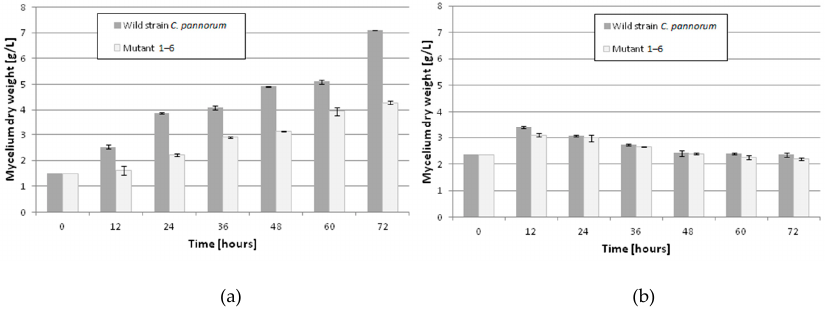
Figure 4 . Cell growth rate of wild-type strain and mutant 1–6 of the fungus C. pannorum A-1 during biotransformation on rich basal medium (BM) ( a ) and 1% glucose medium containing phosphate bu ff er ( b ). Biotransformation conditions: temperature, 20 ◦ C; initial β -pinene concentration, 1% ( v / v ). Bars represent the standard deviation of two independent samples.